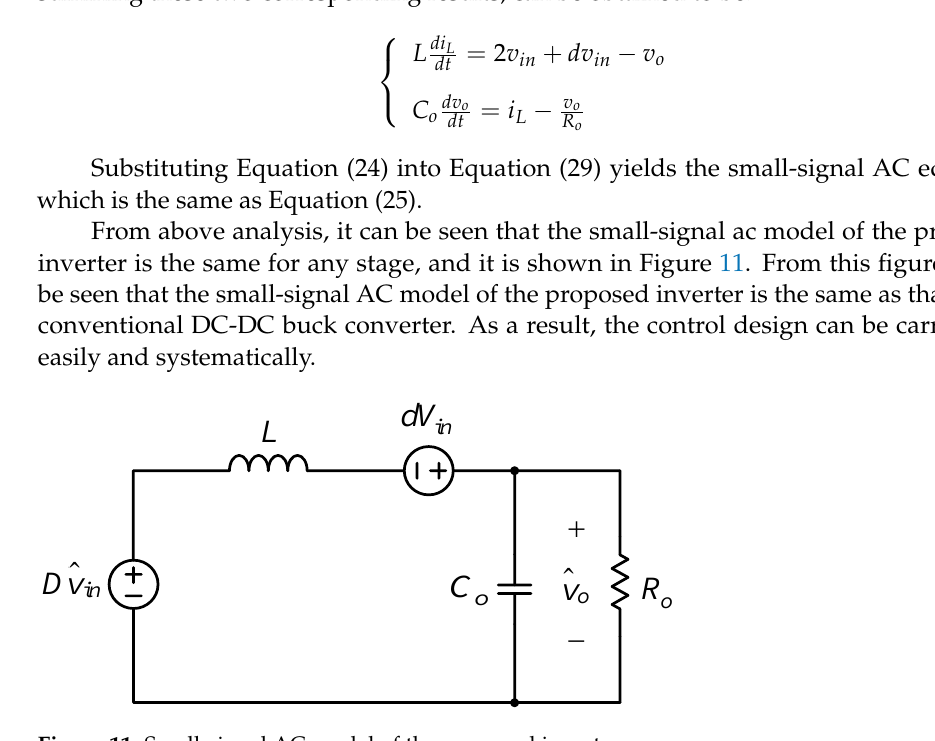
Figure 12. System block diagram for voltage feedback control of the proposed circuit.